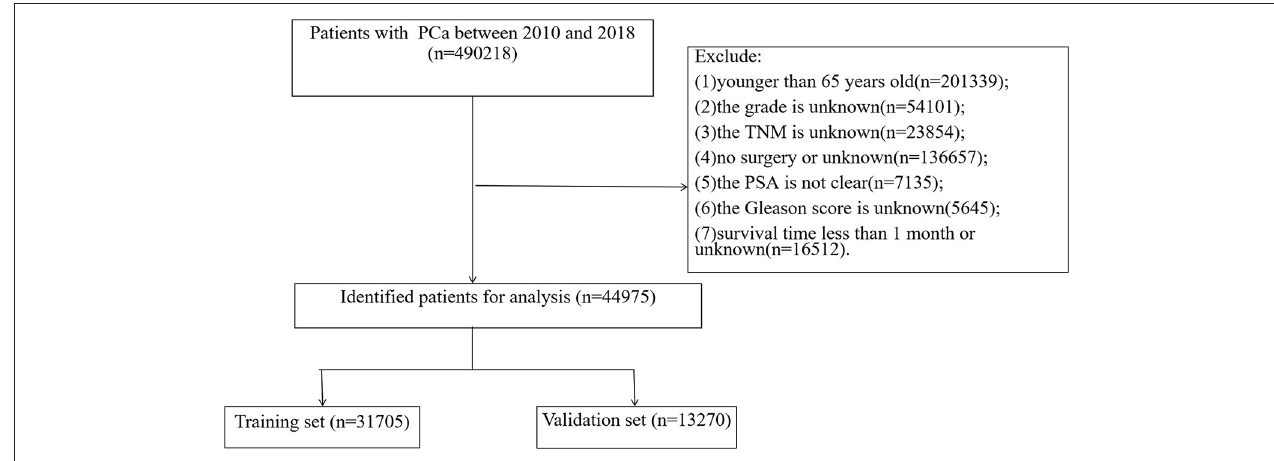
FIGURE 1 | Flowchart for inclusion and exclusion of elderly PC patients undergoing surgery